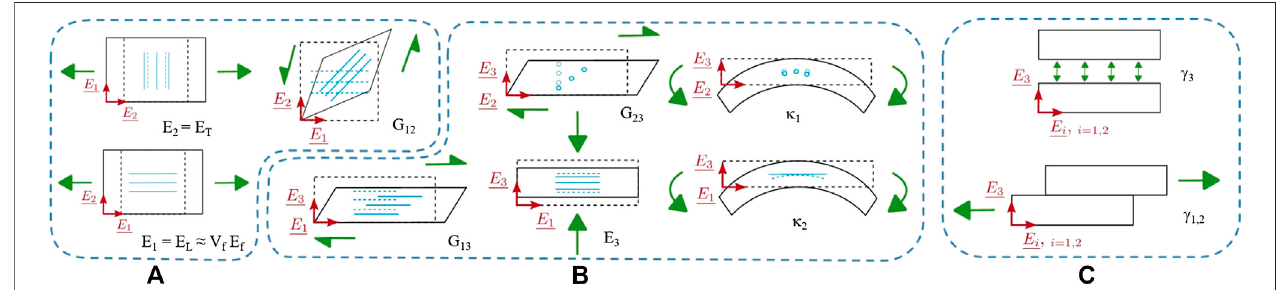
FIGURE 3 | Deformation mechanisms of reinforcements at ply scale during forming, illustrated in the case of a UD with fi bers oriented along E 1 direction: (A) in- plane modes, (B) out-of-plane modes with speci fi c bending about axis E 2 : M (cid:1) B κ 2 , and (C) inter-ply loading with speci fi c inter-ply sliding in plane ( O , E 1 , E 2 ), with friction coef fi cients c 1 , 2